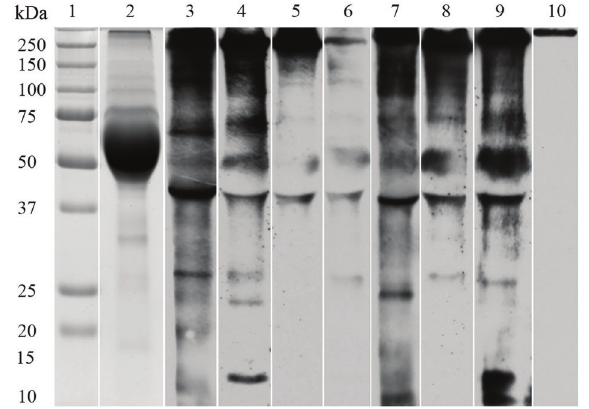
Figure 1. SDS-PAGE and IgE immunoblotting of the crude antigen of E. granulosus cyst fl uid (EgCF). Crude antigen of EgCF protein extracts were incubated individually with 7 sIgE positive sera ( lanes 3 – 9 ), and with disease control ( lane 10 ); crude antigen of EgCF proteins visualized using Coomassie blue R-250 ( lane 2 ); protein molecular weight marker ( lane 1 ). IgE, immuno-